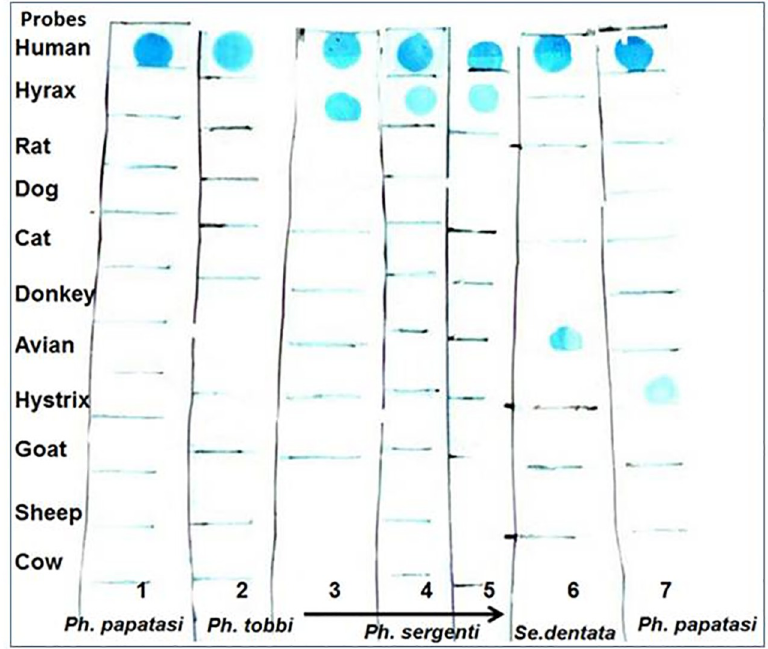
Fig 2. PCR hybridization approach for the identification of the sources of blood imbibed by female sand flies. This is based on the PCR amplification of vertebrate mitochondrial cytochrome b gene sequences combined with reverse dot blot hybridization, which was established and tested according to Boakye et al., 1999, and Abbasi et al., 2009 [3, 5].